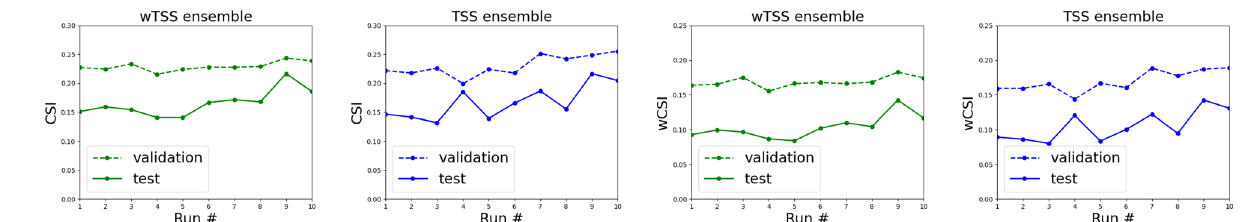
Figure 7. From left to right: CSI values on the validation set (dashed lines) and test set (continuous lines) obtained on each run by applying the wTSS-ensemble strategy (first panel) and the TSS-ensemble strategy (second panel); wCSI values on the validation set (dashed lines) and test set (continuous lines) obtained on each run by applying the wTSS-ensemble strategy (third panel) and the TSS-ensemble strategy (fourth